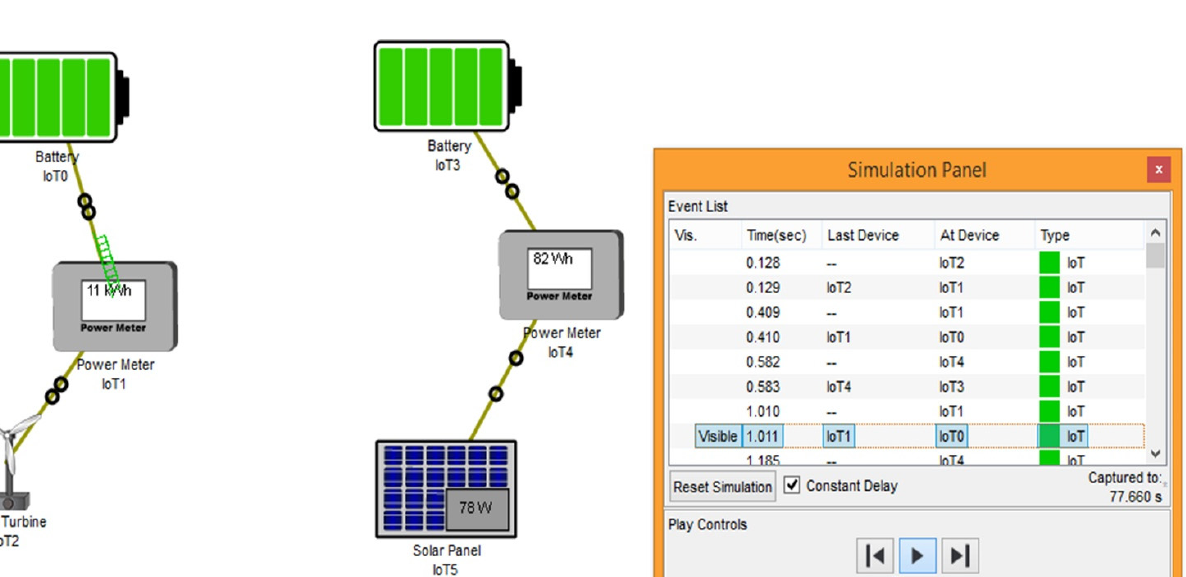
Figure 8. Sensor node communication establishment using LoRa link.